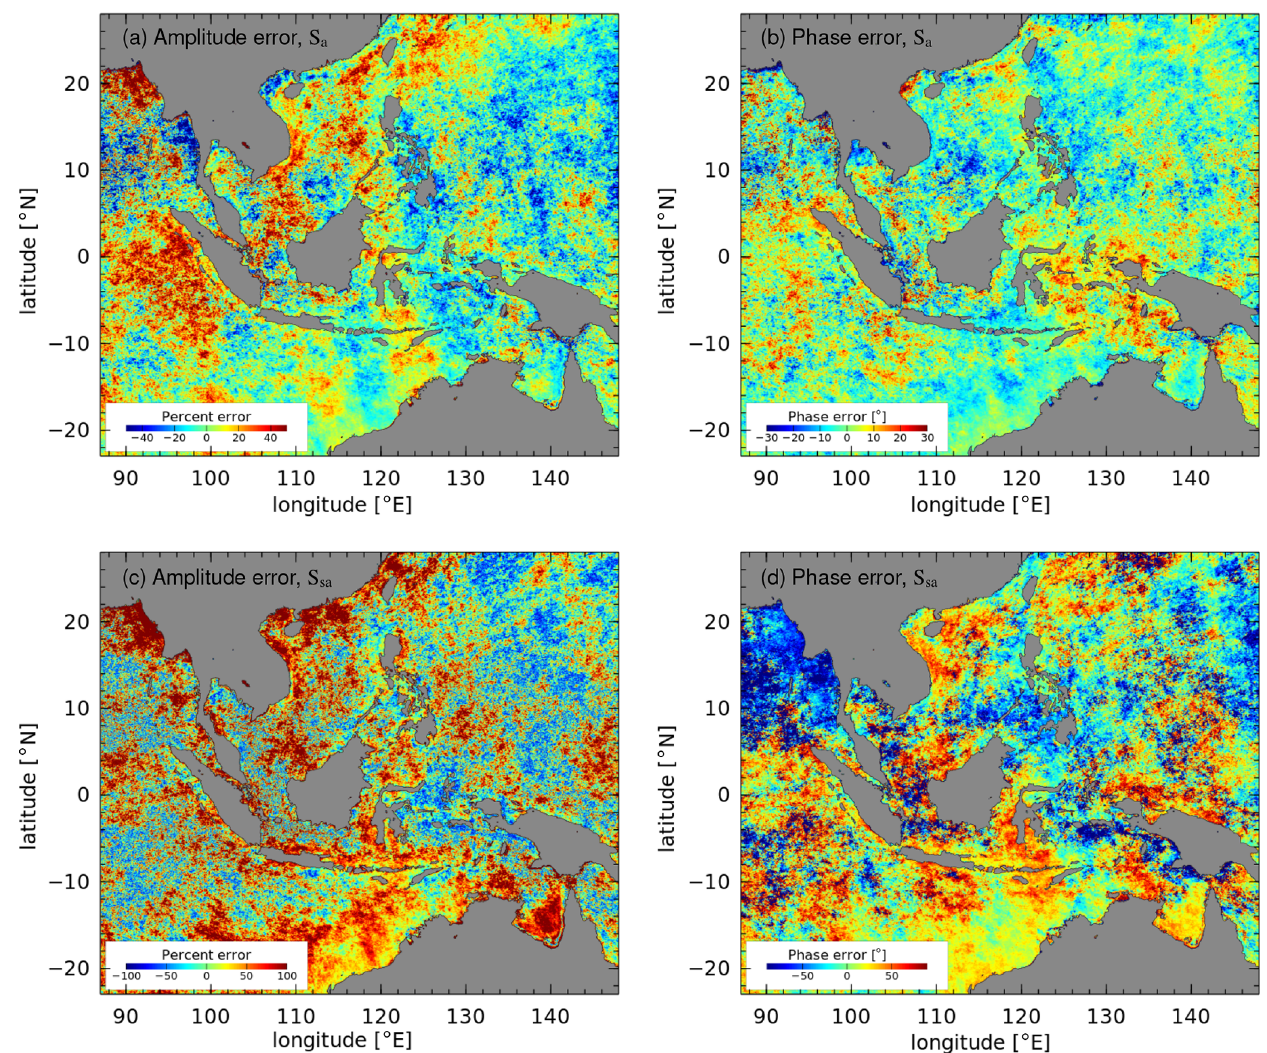
Figure A3. The relative error due to data gaps in amplitude and phase for the harmonic constants at the S a (a, b) and S sa (c, d) frequencies, based on harmonic analysis of a representative time series of NCEP reanalysis meridional winds are shown, similar to Fig. A2. Assuming the low-frequency broadband variability of the wind is similar to Chl a , the S sa harmonic constants are judged as not reliable and are thus omitted from the presentation in the main